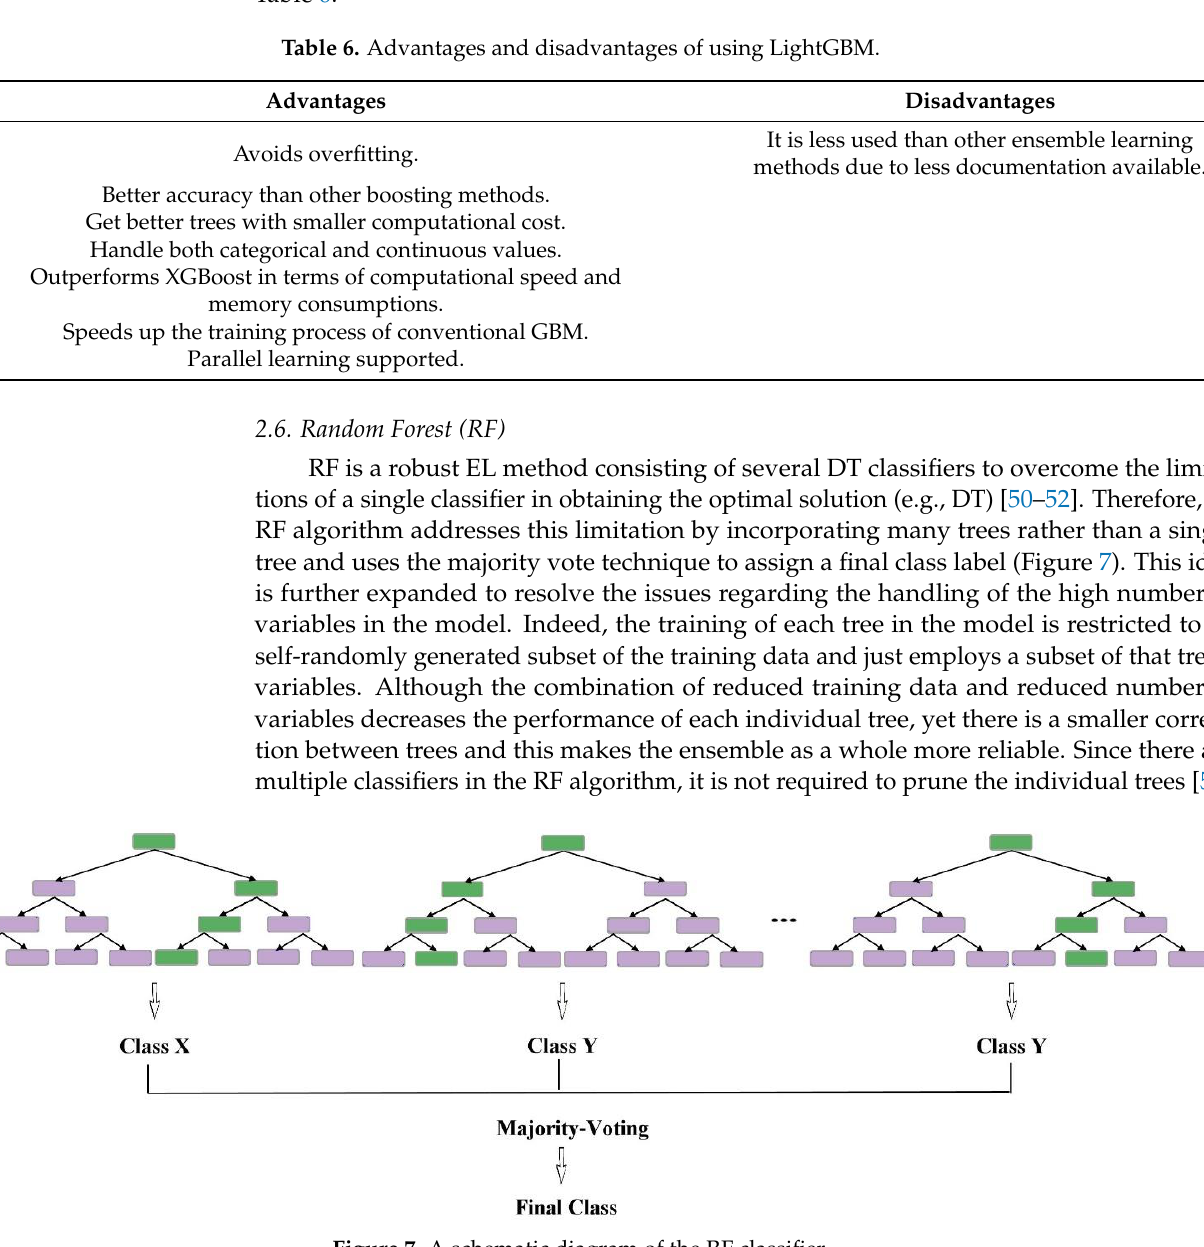
Figure 7. A schematic diagram of the RF classifier.